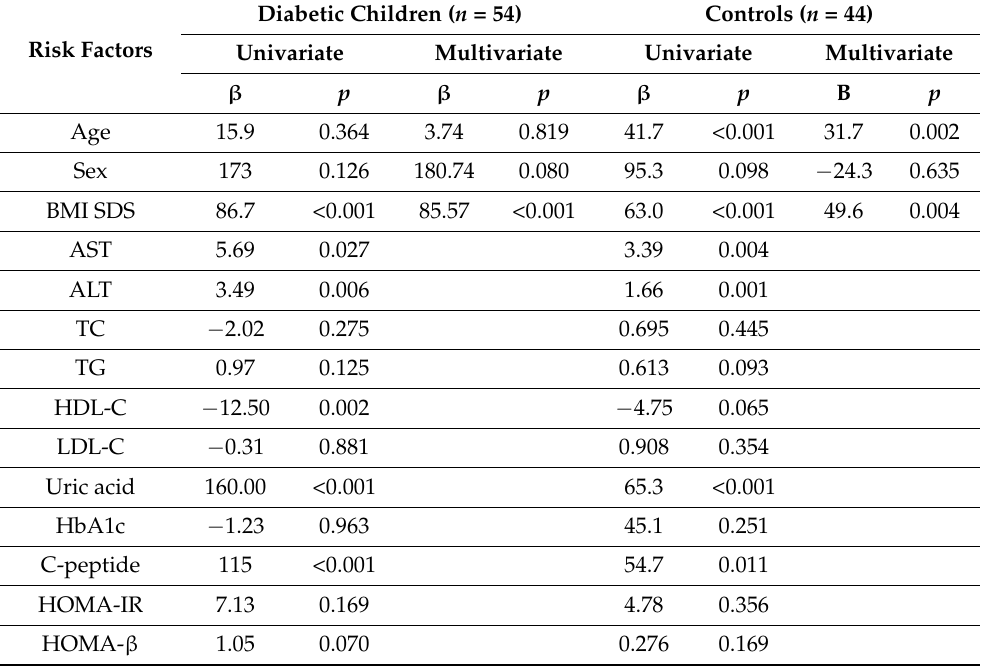
Table 5. Univariate and multivariate regression analyses of factors associated with an increased fetuin-A-to-adiponectin ratio in diabetic children and controls. Diabetic Children ( n = 54) Controls ( n = Risk Factors